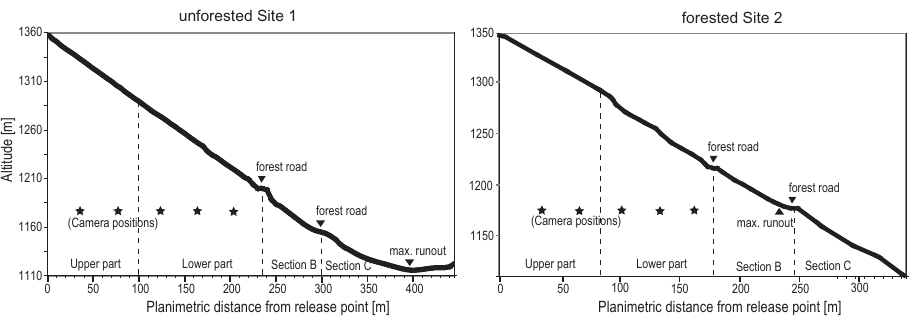
Fig. 1. Profiles of the test sites in Vaujany starting from the release points of the rockfall experiments along the steepest path. Left: unforested Site 1, right: forested Site 2. The camera equipped test sections extend from the top of the slope down to the upper forest road. The observed run-out zones extend further (maxima indicated by triangles).